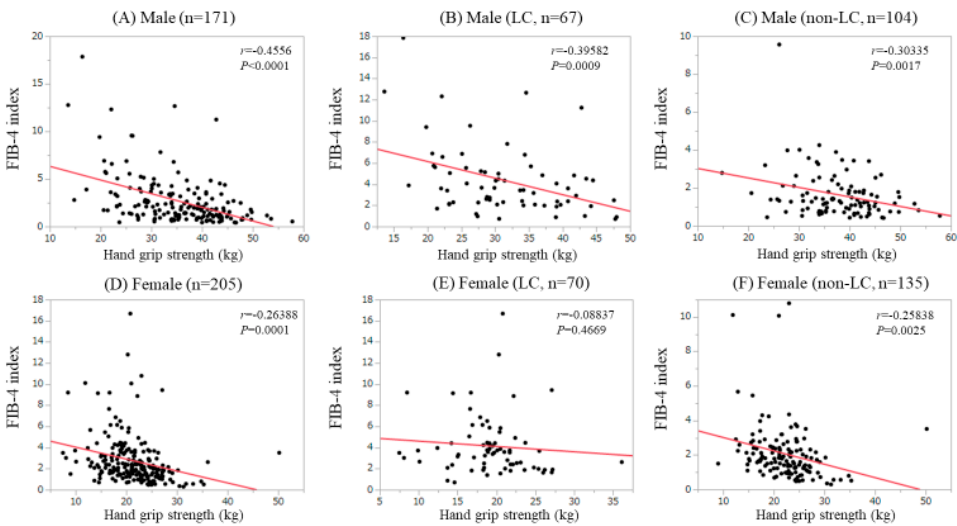
Figure 5. Correlation between GS and the Fibrosis-4 (FIB4) index; ( A ) Male cases; ( B ) LC male cases;